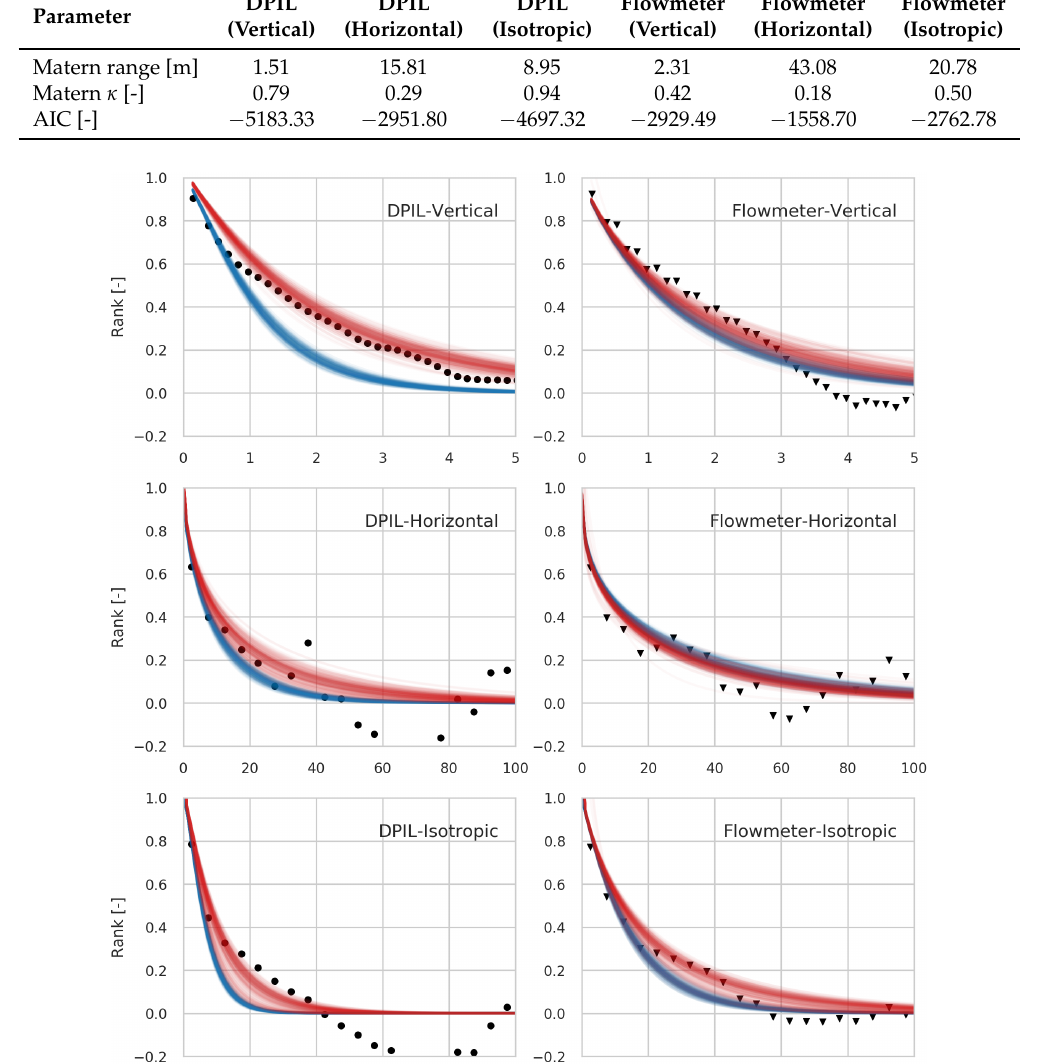
Table 3. Representative parameter estimates for the Gauss-copula model based on 200 randomly sampled data subsets of size 10, with the related Akaike information criterion (AIC).